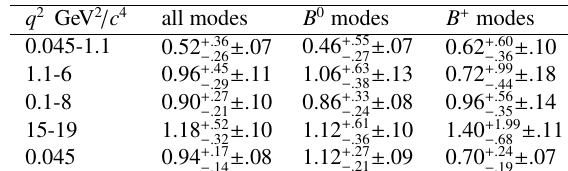
Table 1: Results for R K ∗ , R are statistical and the second are